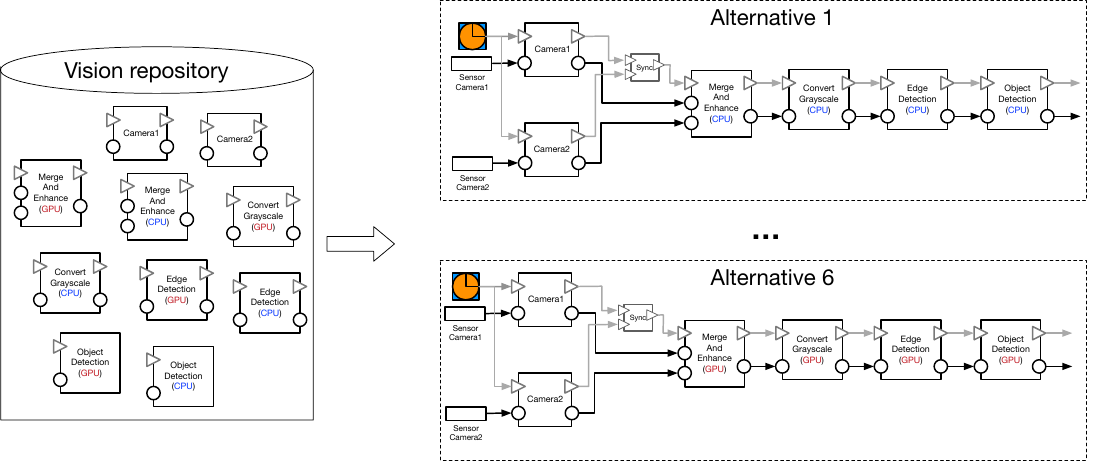
Figure 2. The vision system alternatives. GPU, graphics processing units; CPU, central processing